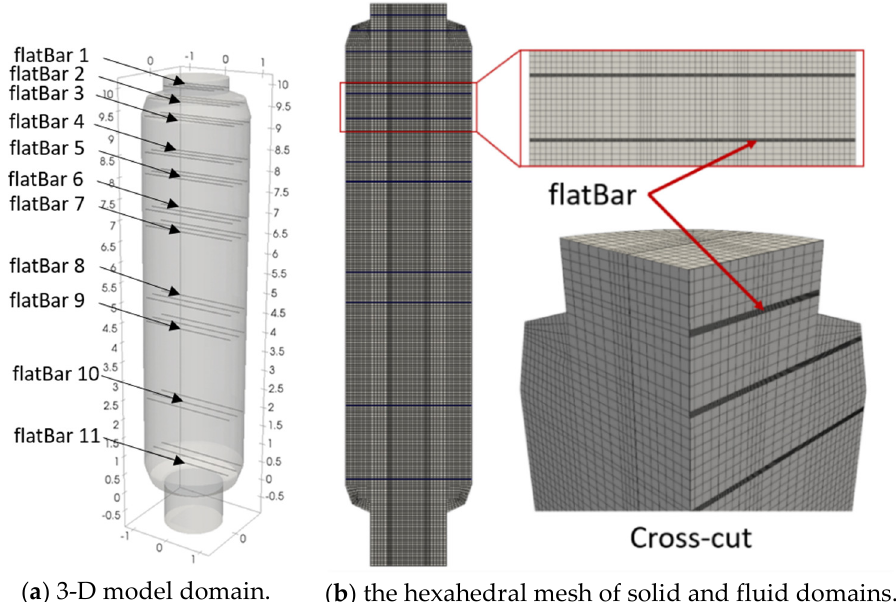
Figure 2. Three-dimensional model geometry and mesh.